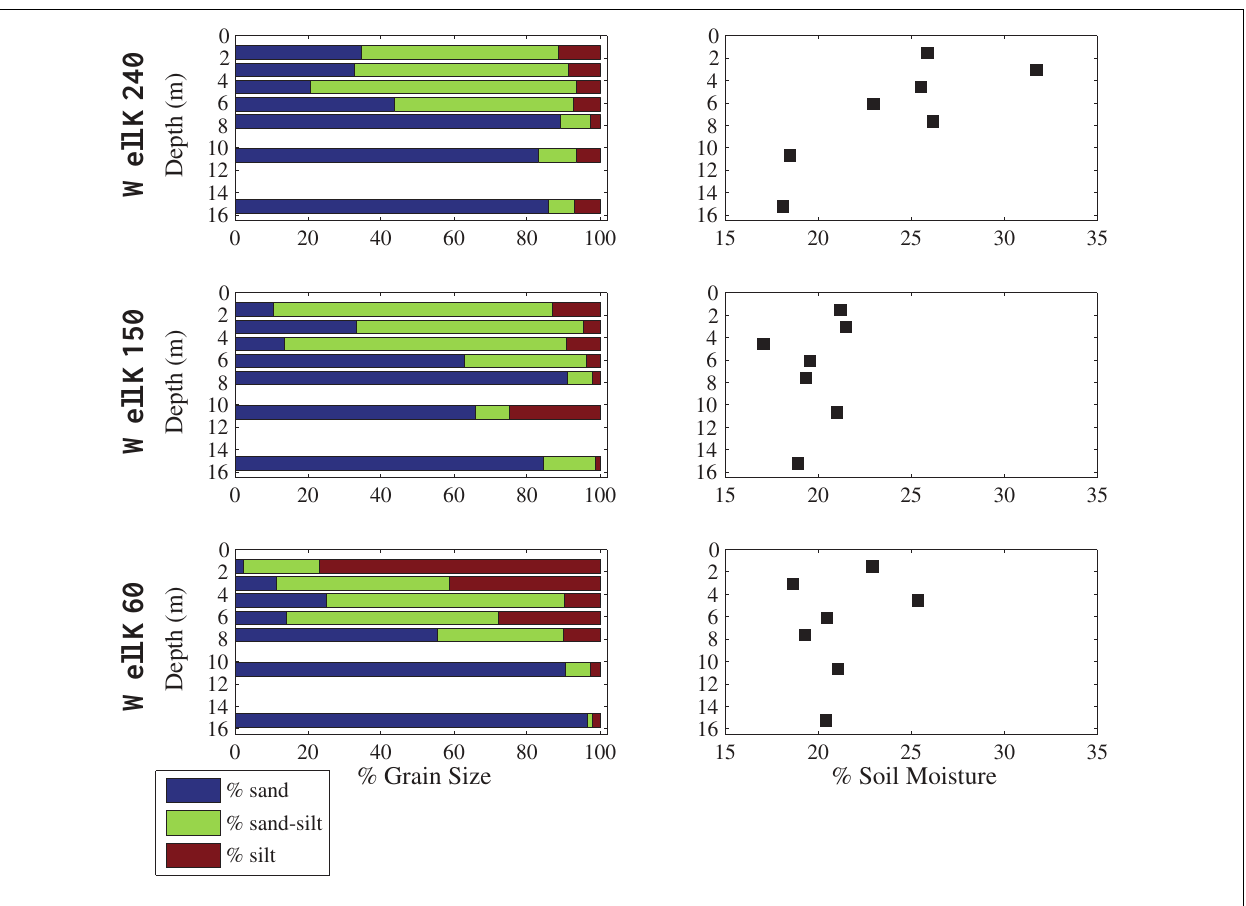
FIGURE 2 | Grain size distribution and soil moisture of sediments collected at depths of 1.52, 3.05, 4.57, 6.10, 7.62, 10.67, and 15.24m at the three sampling locations along the groundwater flowpath at Site K.